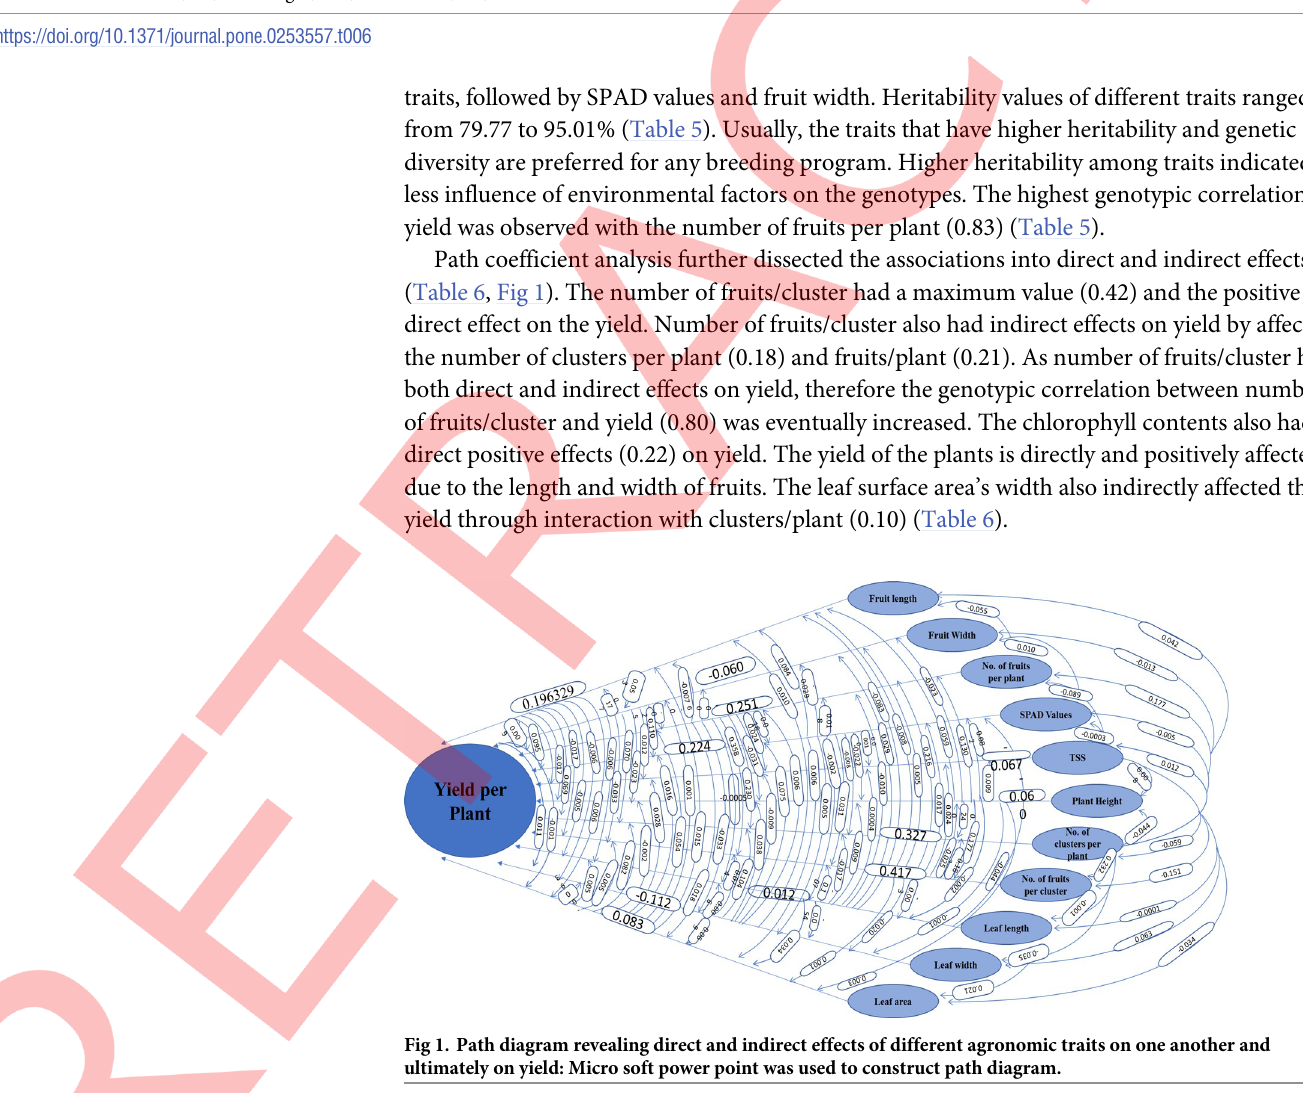
Fig 1. Path diagram revealing direct and indirect effects of different agronomic traits on one another and ultimately on yield: Micro soft power point was used to construct path diagram.